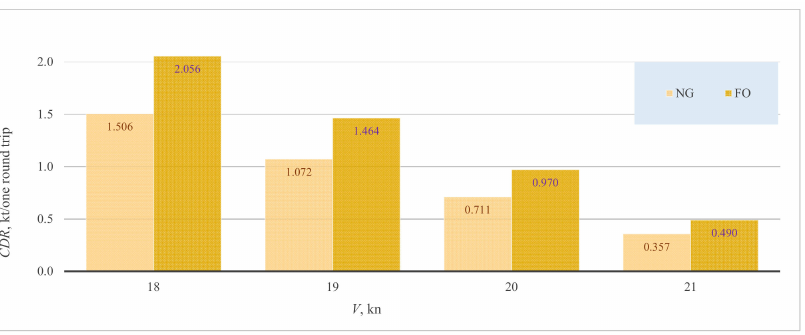
Figure 26. The CO 2 emission reduction per one trip for FO- and NG-fueled mode under